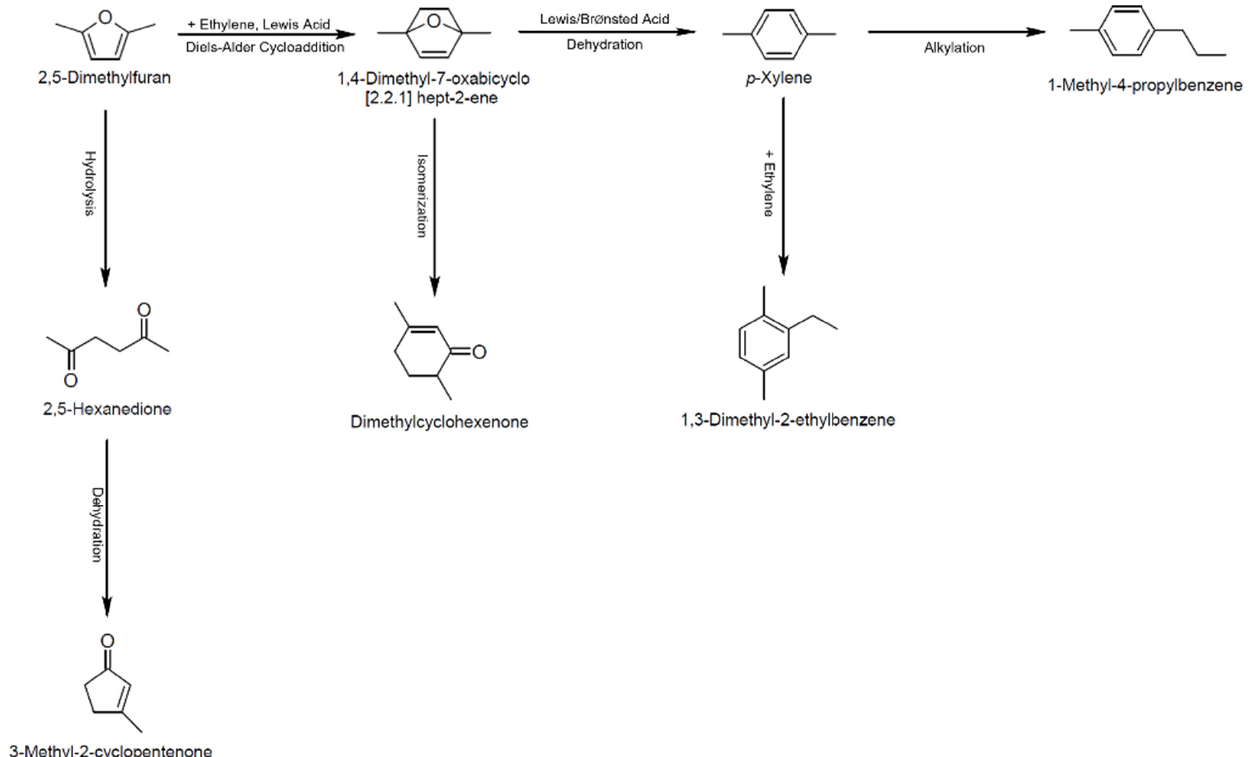
Figure 1. Overall schematic diagram of Diels–Alder reaction of DMF and